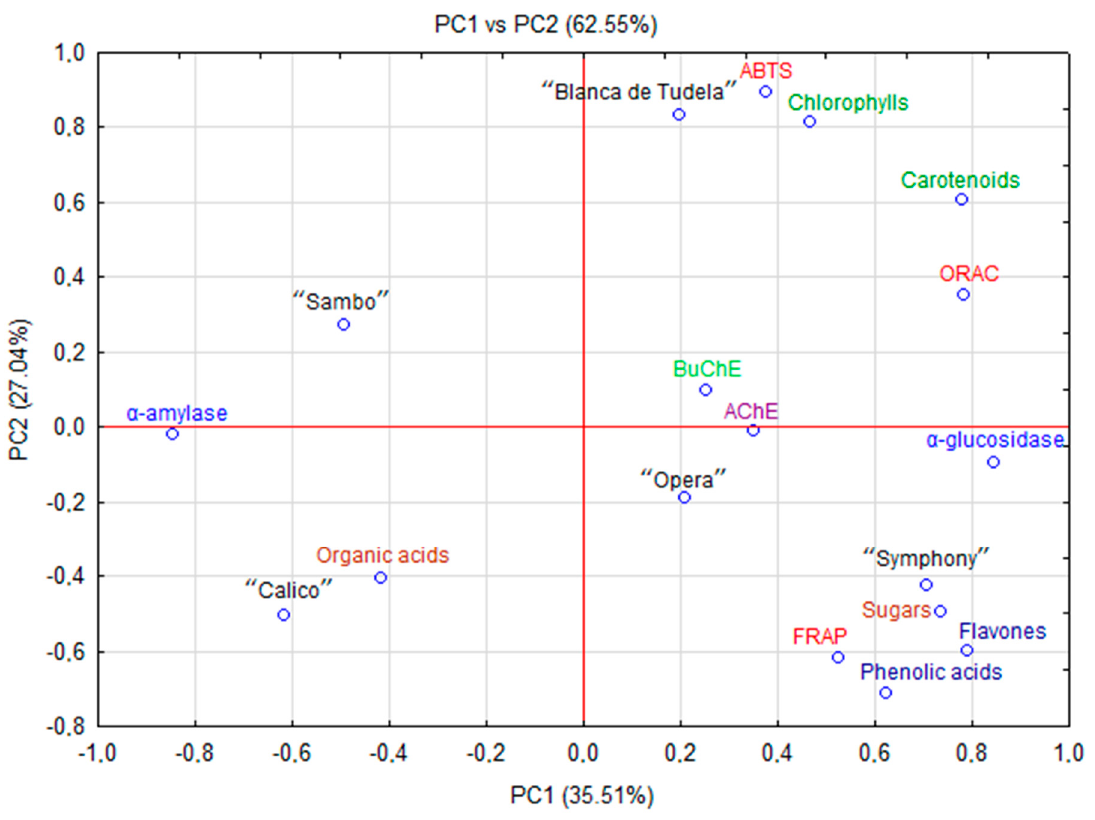
Figure 3. PCA scores plot showing the relationship among chemical parameters and biological activity of new varieties and hybrids of artichoke.